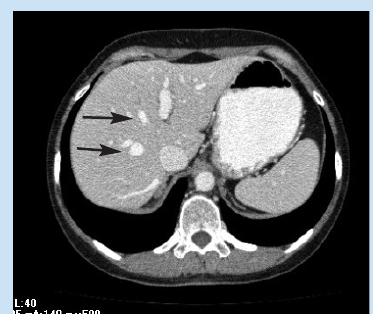
Fig. 10. Delayed scan at the same level show- ing the filling of hepatic veins. Spleen now has uniform enhancement.